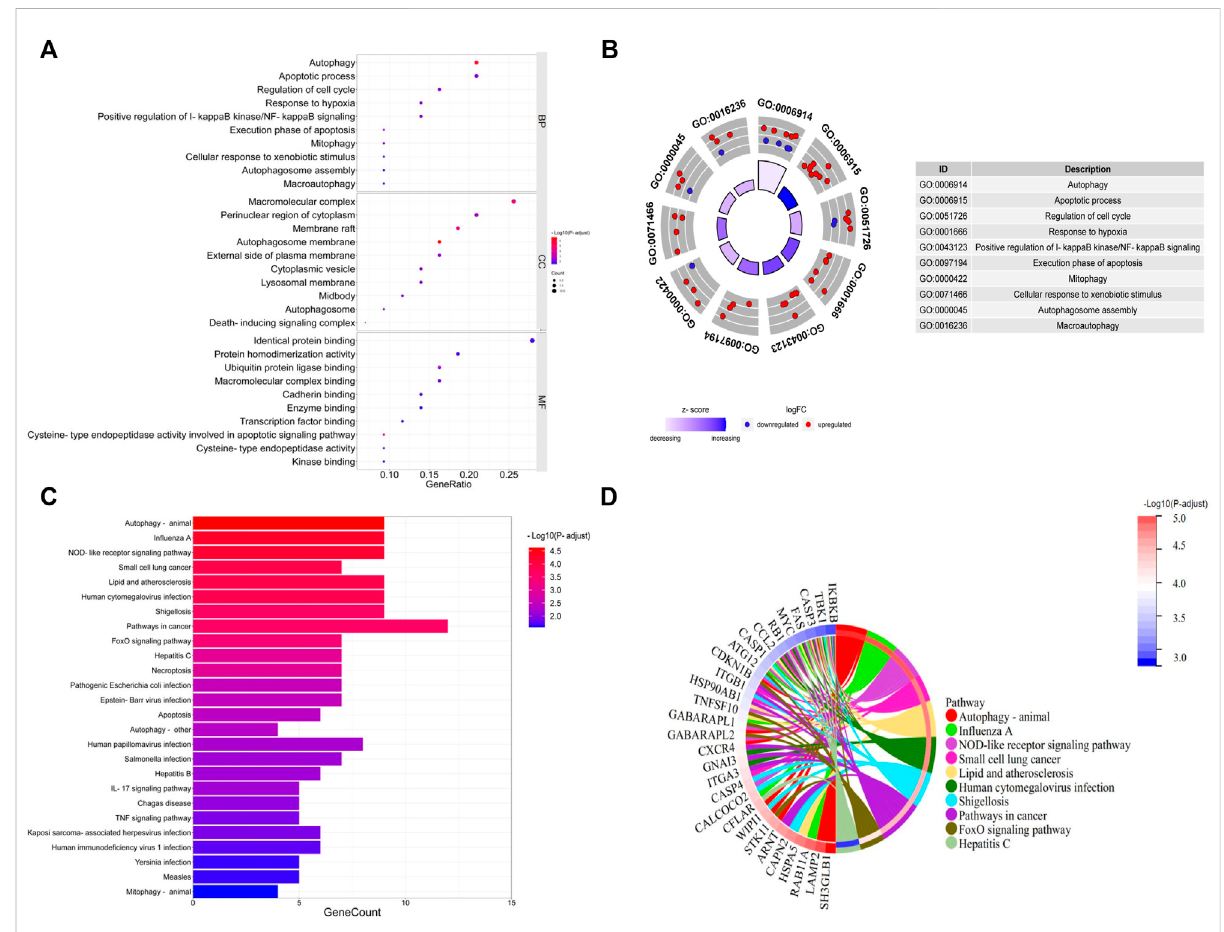
FIGURE 3 GO andKEGG enrichmentanalyses of 43differentiallyexpressedautophagy-relatedgenes. (A, B) Bubbleplotand circle plotofGO enrichment terms. BP, biological process; CC, cellular component; MF, molecular function. (C, D) Bar plot and Chord plot of KEGG enrichment pathways. GO, Gene Ontology; KEGG, Kyoto Encyclopedia of Genes and